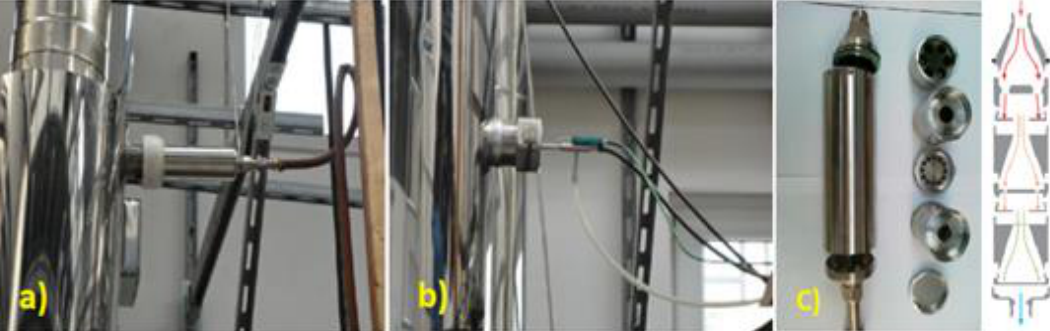
Figure 4. Measuring probes: ( a ) probe for measuring PM production; ( b ) probe for measuring chimney temperature and flow rate; ( c ) layout of cascade sampling probe parts.